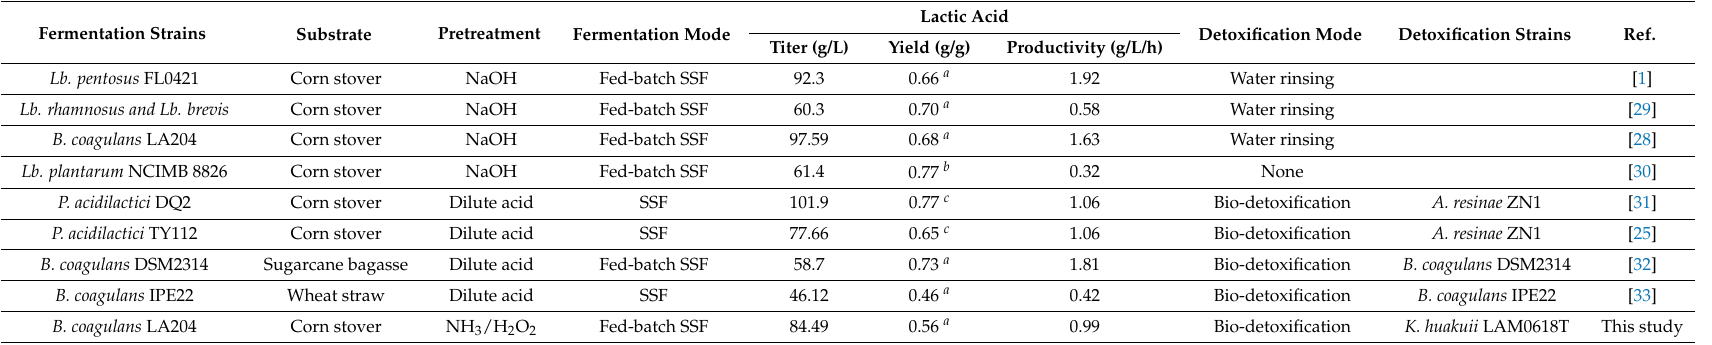
Table 2. Summary of recent publications on lactic acid fermentation from detoxified and non-detoxified lignocellulosic materials through